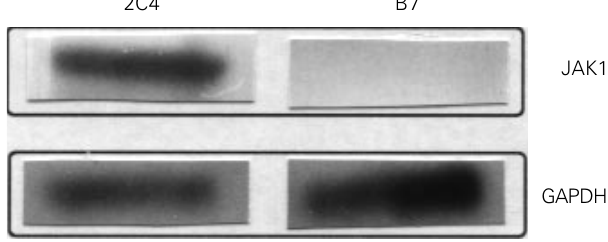
Figure 4 - Northern analysis of JAK1 mRNA. Five (cid:181)g of poly A + RNA from the parental cell line 2C4 and the B7 mutant was hybridized with a human JAK1 cDNA probe as indicated. GAPDH was used as an internal standard for RNA